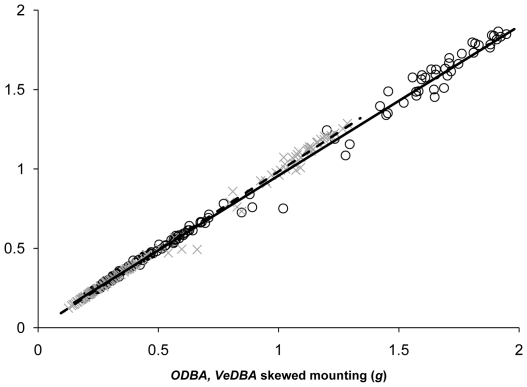
Dynamic body accelerations (ODBA – circles, and VeDBA –crosses) from straight- versus skew-mounted accelerometers (for details see text).Each point denotes a mean value derived from a three-minute trial of a participant moving at one particular speed below the lactate threshold. Data from all participants are included.